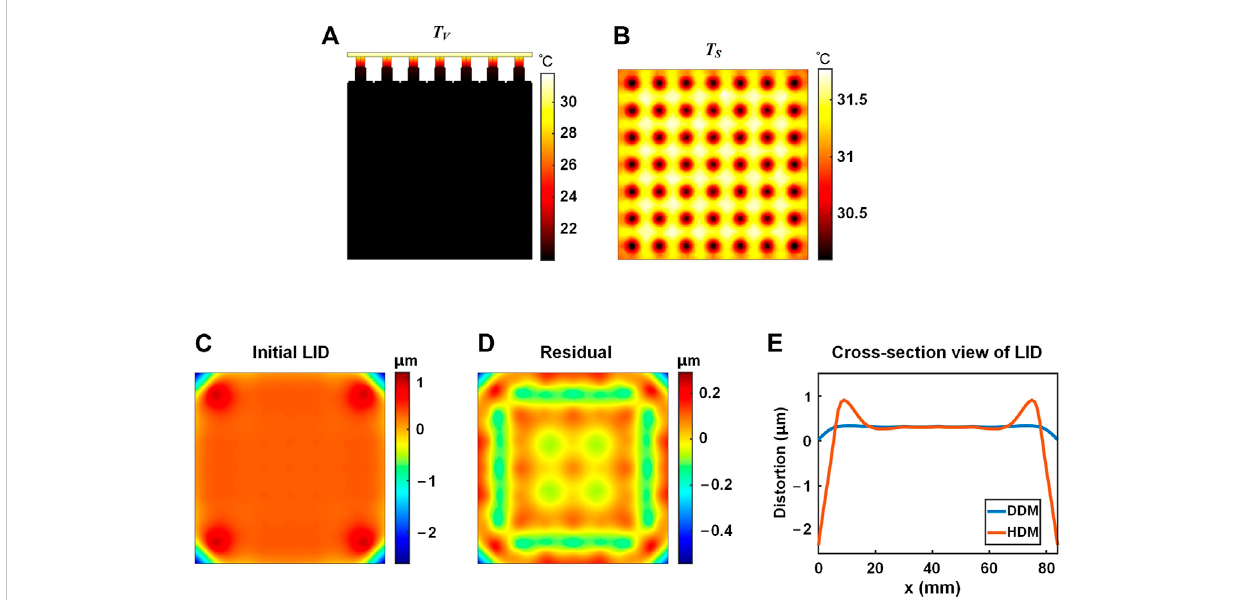
FIGURE 5 TemperaturedistributionandLIDoftheHDMunder60 slaserirradiation. (A) Overalltemperaturedistribution T V . (B) Mirrortemperaturedistribution T